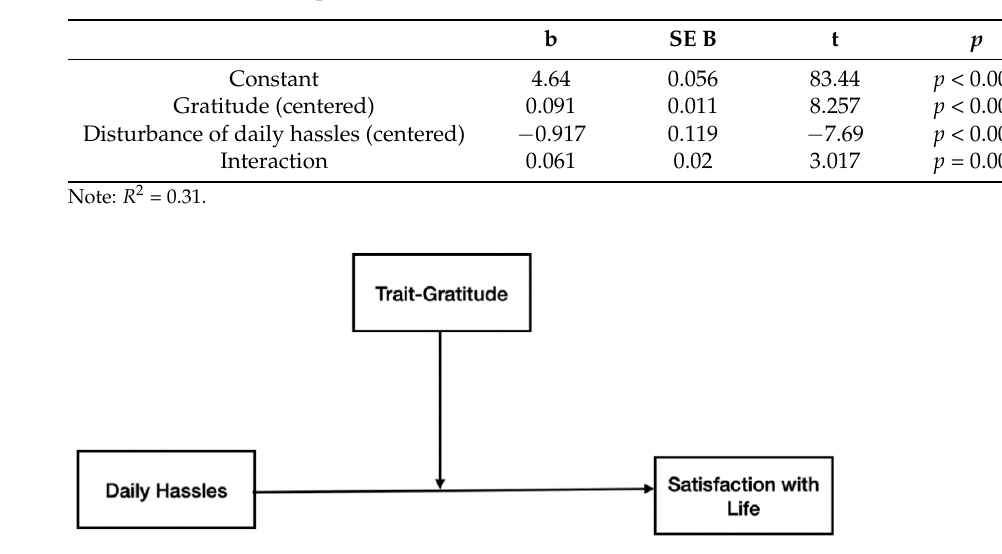
Figure 2. Moderation model of gratitude moderating the relation between daily hassles disturbance and satisfaction with